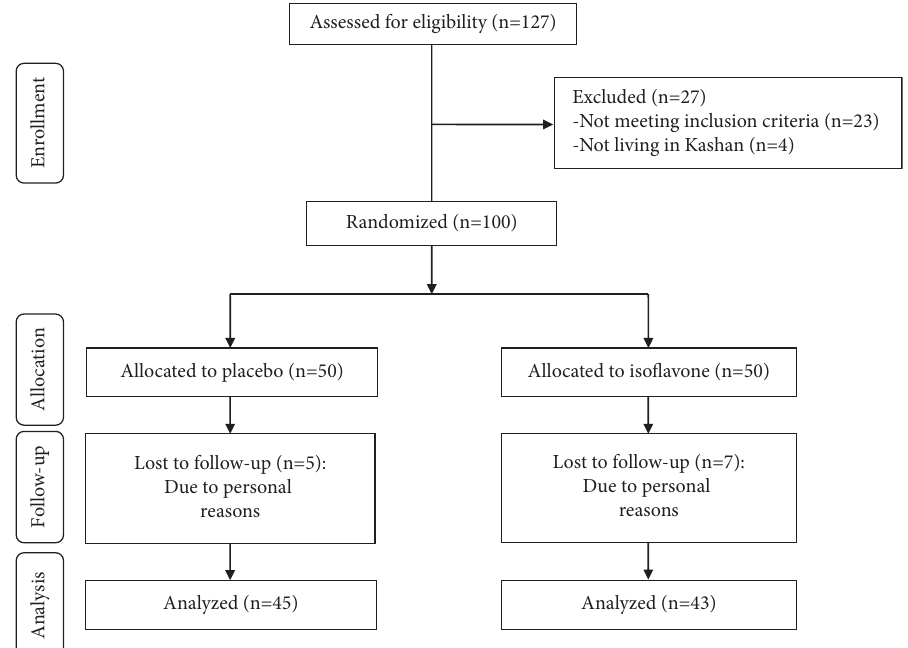
Figure 1: Summary of the patient fow